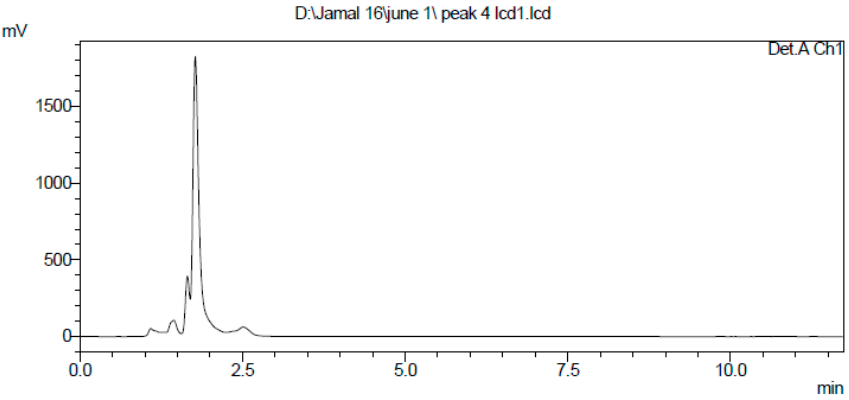
Figure 3. High performance liquid chromatography (HPLC) spectrum of the purified antifungal compound from B. amyloliquefaciens Y1.